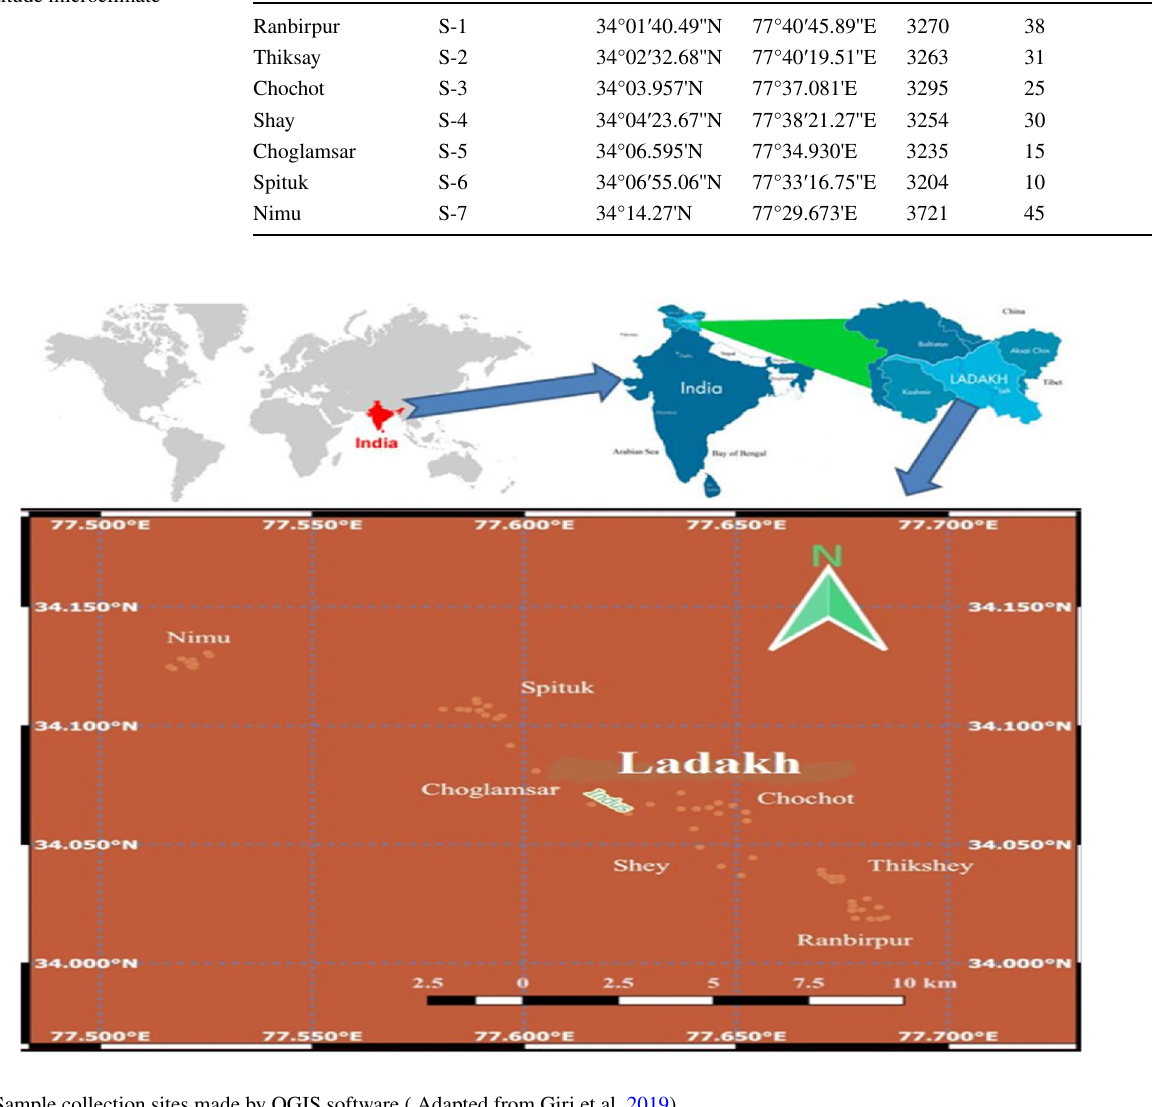
Fig. 1 Sample collection sites made by QGIS software ( Adapted from Giri et al.